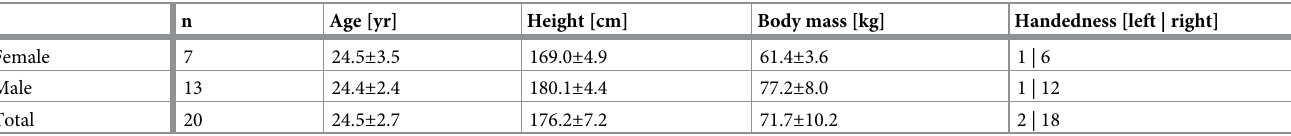
Table 1. Demographic data of the participants (mean ±